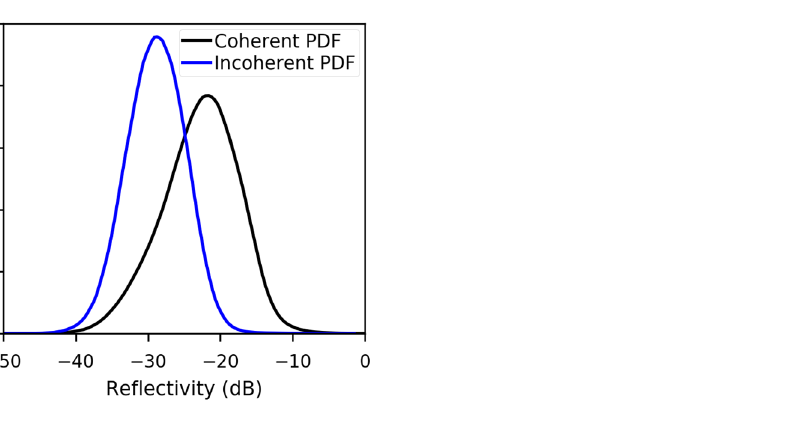
Figure 9. The probability density function of coherent and incoherent reflectivity derived from CYGNSS land observations in January 2018.